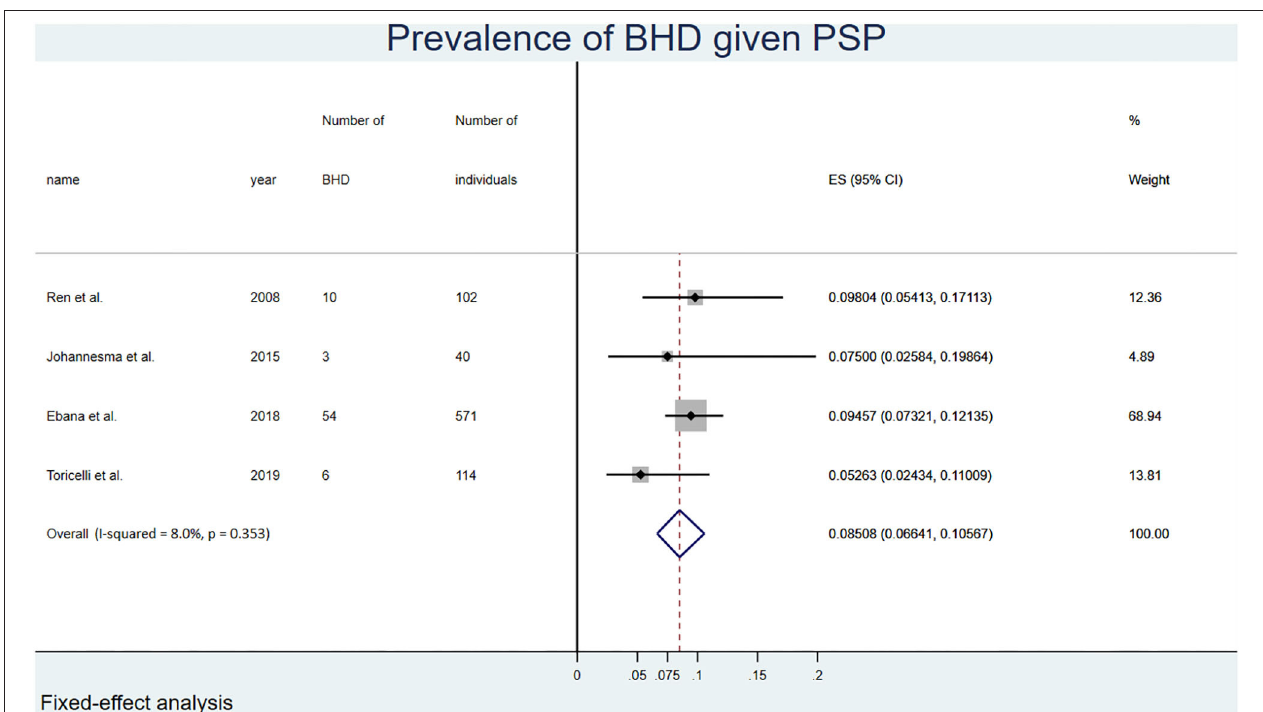
FIGURE 1 | Forest plot of the overall prevalence of BHD in PSP, random-effects